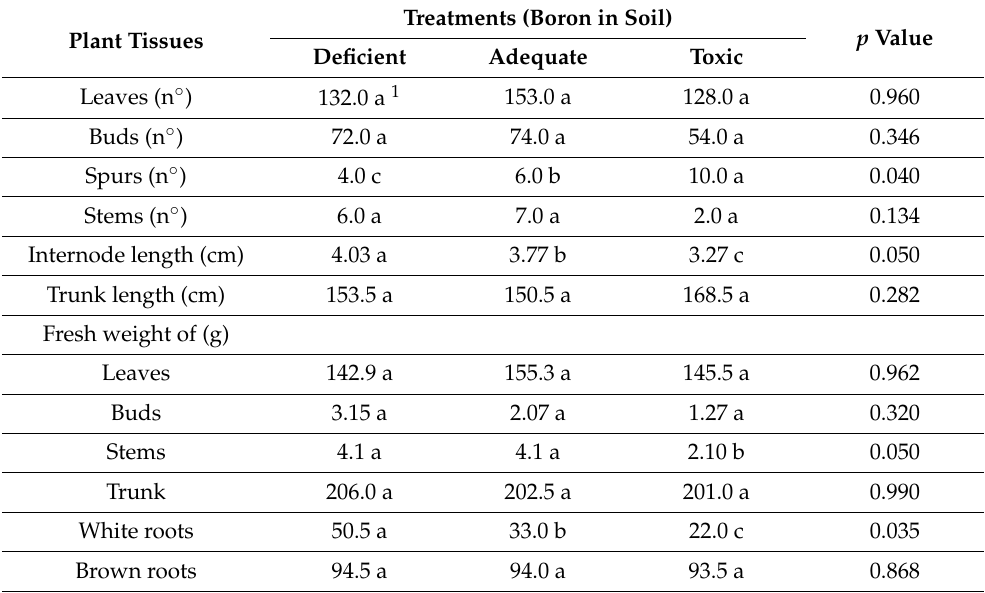
Table 1. Effect of three concentrations of soil boron availability, deficient, adequate, and toxic (0.04,